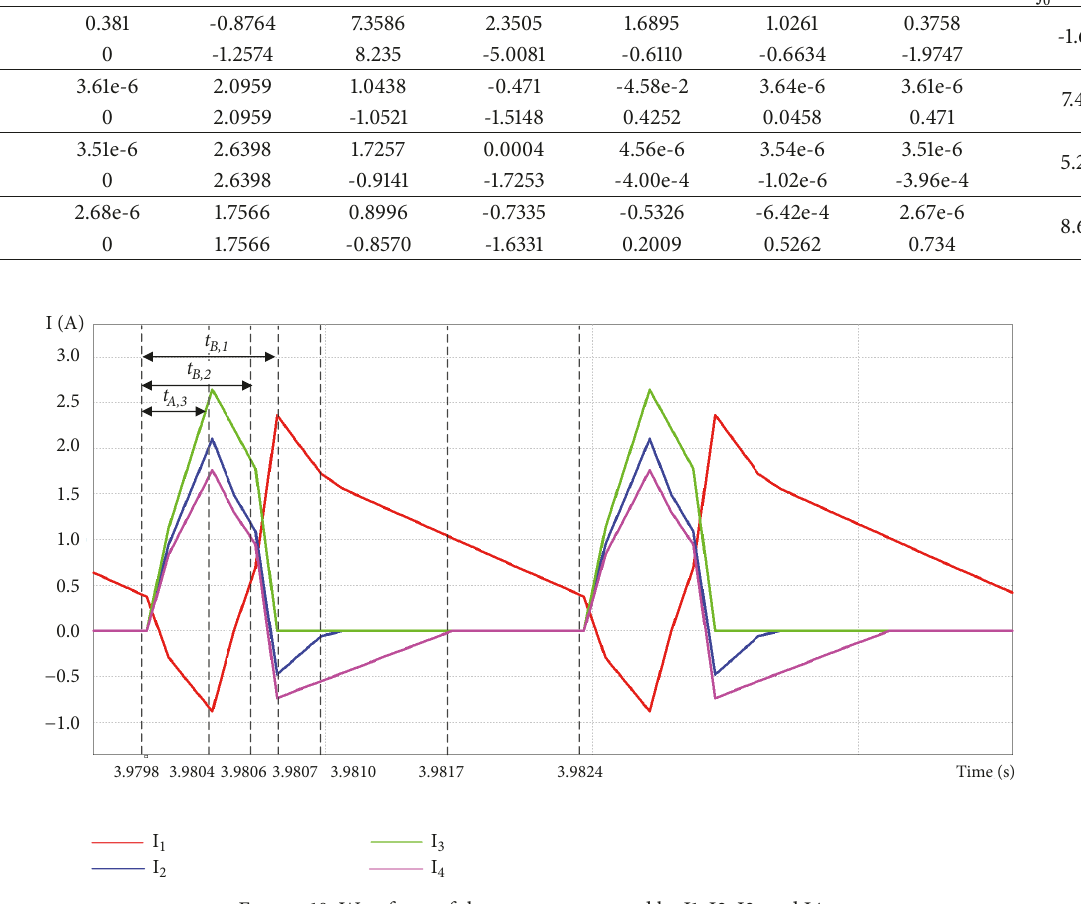
Figure 10: Waveform of the current measured by I1, I2, I3, and I4.